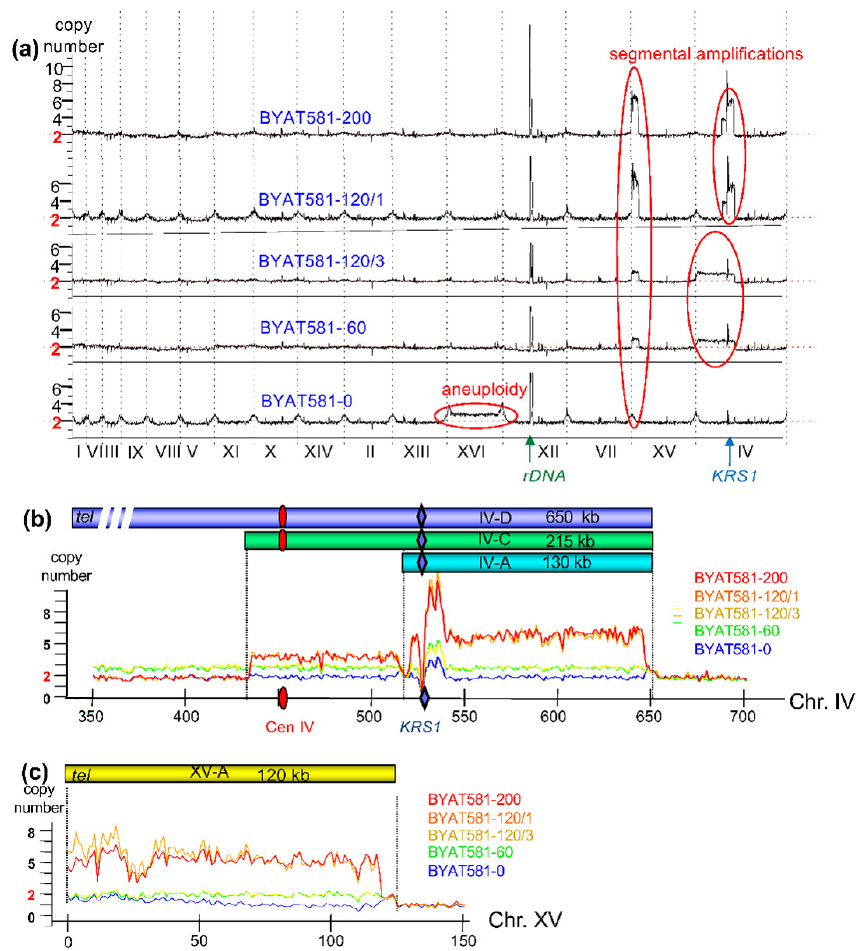
Figure 2. Copy number variation along chromosomes in evolved mutants. ( a ): For each sequenced strain, the copy number of each locus (ordinate) was plotted along the 16 chromosomes of the S288c reference sequence ranked by increasing size (abscissa, roman numerals). Copy numbers were computed from local sequence coverage (number of reads) relative to the median coverage for that strain (see Section 2.4) and normalized to 2 (diploids). Curves were smoothed using 5000 nucleotide sliding windows. The peak corresponding to rDNA was artificially cut for drawing clarity. Regions of increased copy number are red-circled. ( b ): Zoom of copy number variations along chromosome IV as determined from sequence coverage of BYAT581-0 and evolved mutants (color coded). The locations of centromere (red oval) and KRS1 (blue diamond) are indicated. The excess sequence coverage immediately at the right of KRS1 corresponds to the tandem copies of ENA genes (9 in these strains instead of 3 [11]). Horizontal bars on top materialize amplicon units. ( c ): Zoom of copy number variations along chromosome XV (same legend as in b